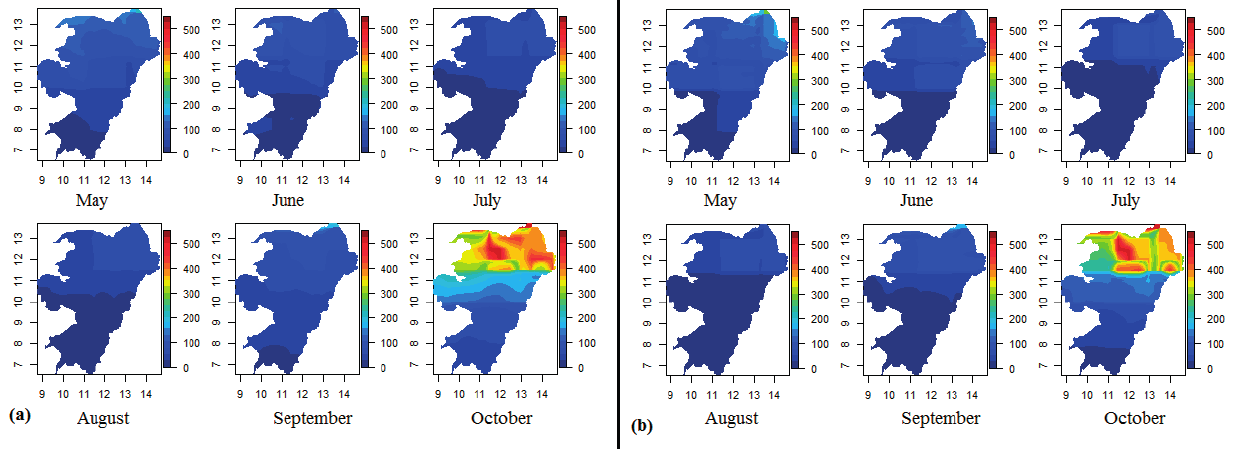
Figure 1. Maps of the CV of ( a ) monthly rainfall over a 27-year period (1980–2006) and ( b ) the frequency (number of rain days) in a month from May–October. Both are shown as percent values. The axes show the latitude (North) and longitude (East) coordinates in